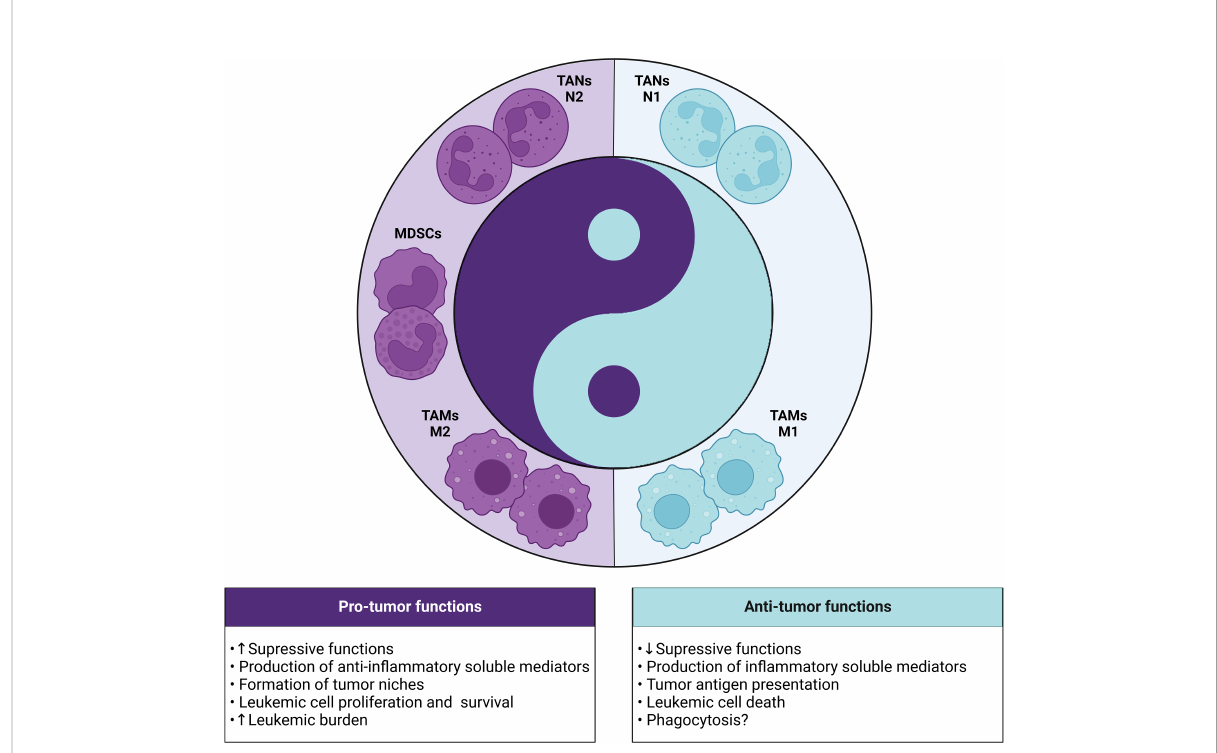
FIGURE 4 Yin-Yang with the dual role (pro and antitumor) of myeloid cells in the leukemic microenvironment. In leukemia, the different subsets of myeloid cells (TANs, TAMs and MDSCs) can exert dichotomous functions dictated by the polarization status of each cell. The pro-tumor phenotype is highlighted by the presence of N2 TANs, M2 TAMs and MDSCs, which show strong immunosuppressive activity through the production of anti- in fl ammatory mediators and formation of leukemic niches that contribute to the increase in tumor burden. In contrast, the antitumor phenotype involves the presence of N1 TANs and M1 TAMs that can exert protective functions through the release of cytotoxic mediators, tumor antigen presentation, death or phagocytosis of leukemic